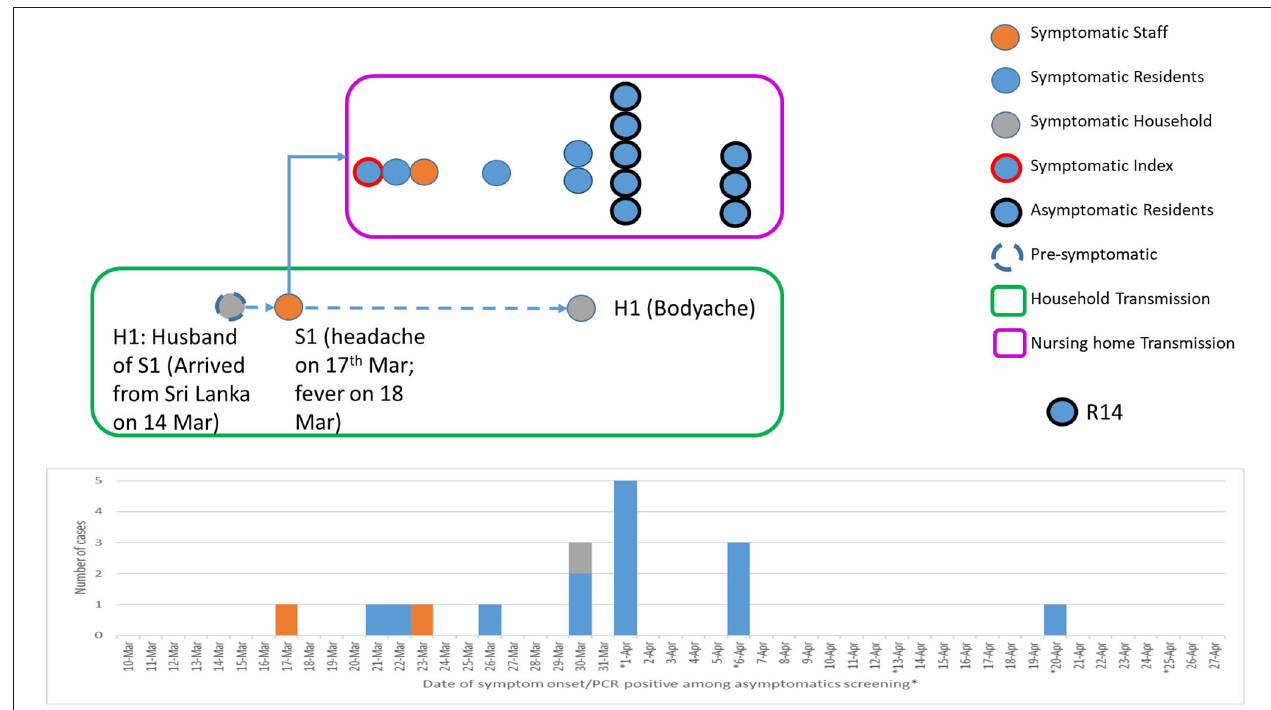
FIGURE 4 | Epidemiological transmission and linkages between a household cluster and nursing home cluster. Pre-symptomatic household transmission occurred from H1 (husband of S1; travel history to Sri Lanka and returned on March 14) to S1 (wife of H1; staff nurse of a nursing home). This led to the introduction of the severe acute respiratory syndrome coronavirus 2 (SARS-CoV-2) transmission within the nursing